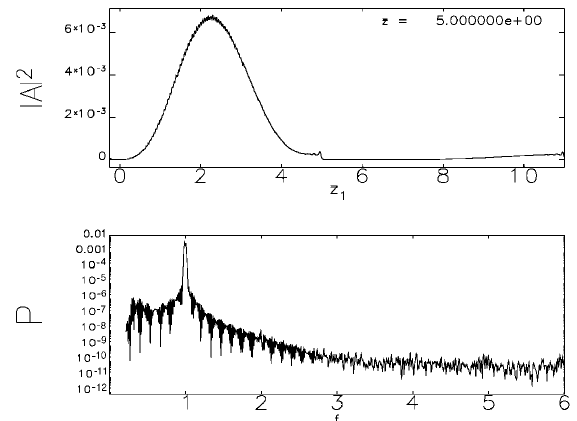
FIG. 5. Top panel: The filtered, scaled intensity, j A j 2 , as a function of scaled pulse position (cid:9) zz through the interaction region of (cid:9) zz (cid:1) 5 and a rectangular profile electron pulse duration of (cid:9) ll The slippage region is 0 < (cid:9) zz < 6 ; the vacuum region is (cid:9) zz (cid:9) zz 1 scaled PSD, P , of the radiation as a function of the scaled frequency f .